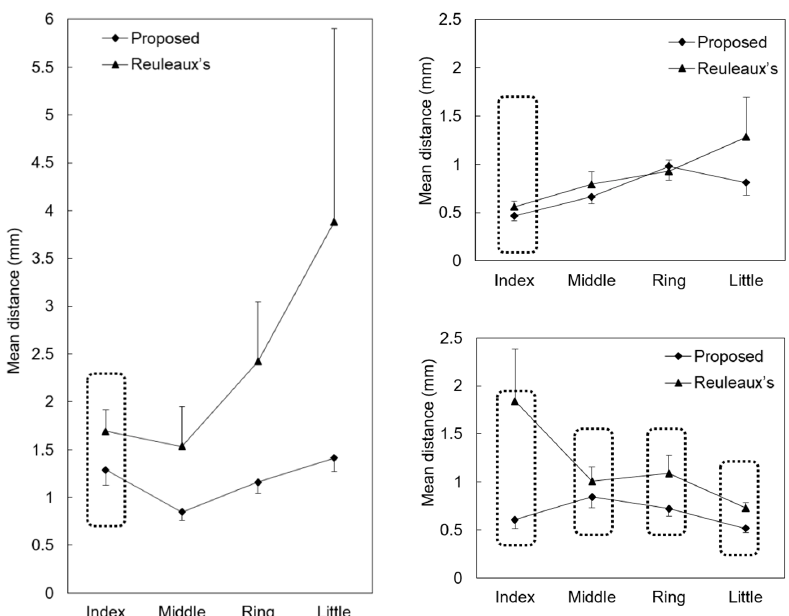
Figure 11. Mean distances and standard errors among the estimated finite joint centers of rotation by the proposed method and Reuleaux’s method at the metacarpophalangeal (left), proximal interphalangeal (upper right), and distal interphalangeal (lower right) joints of the index, middle, ring, and little fingers (dotted box: significant difference at α = 0.05).